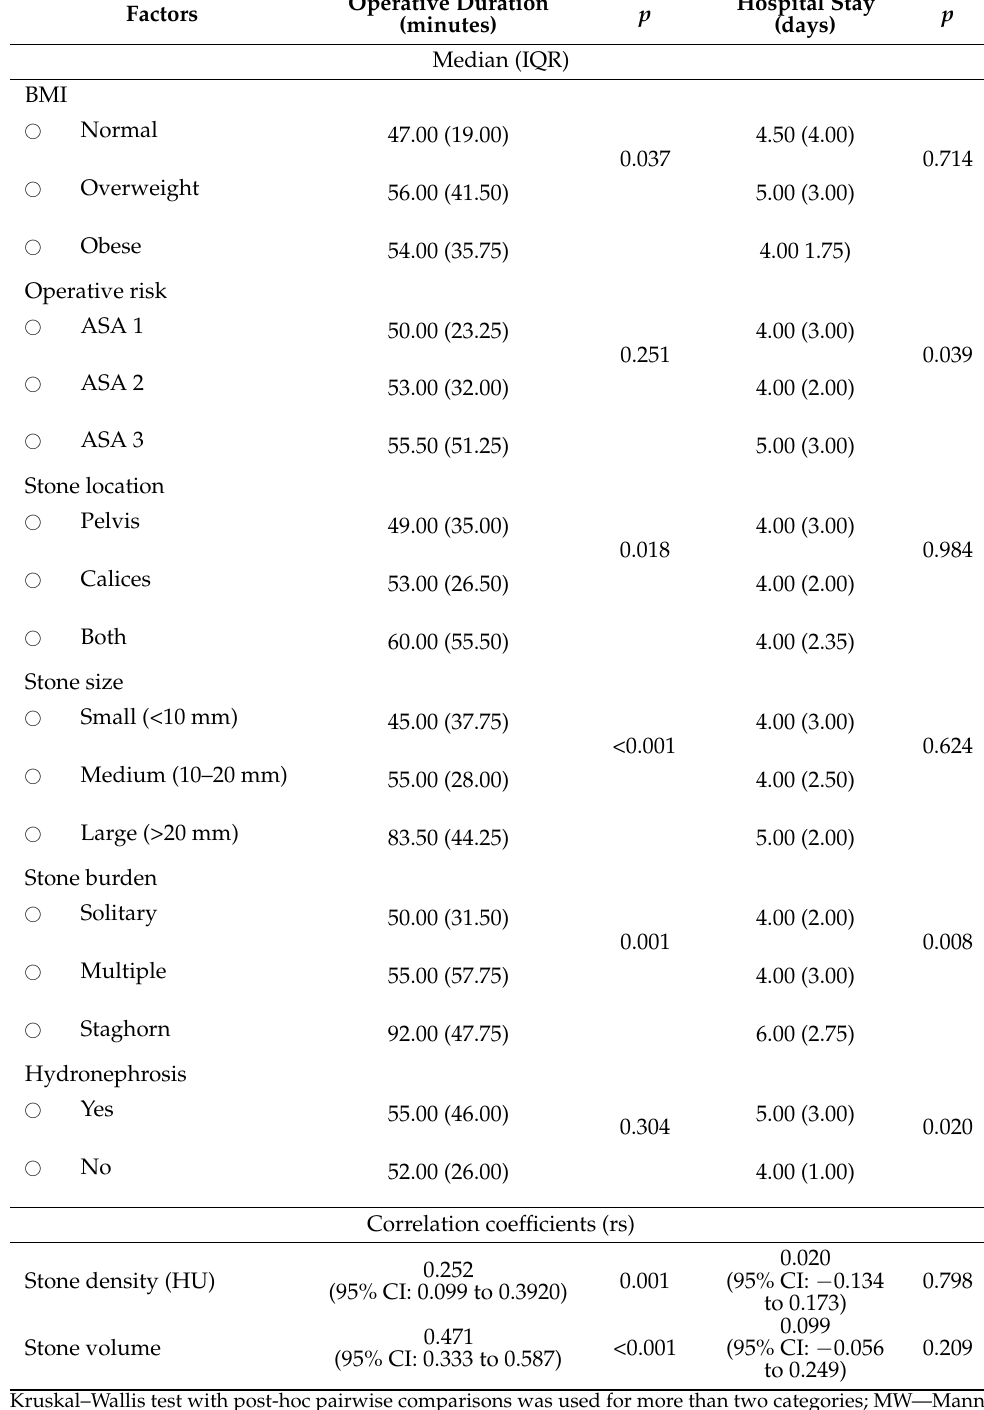
Table 4. Factors influencing operative duration and hospital